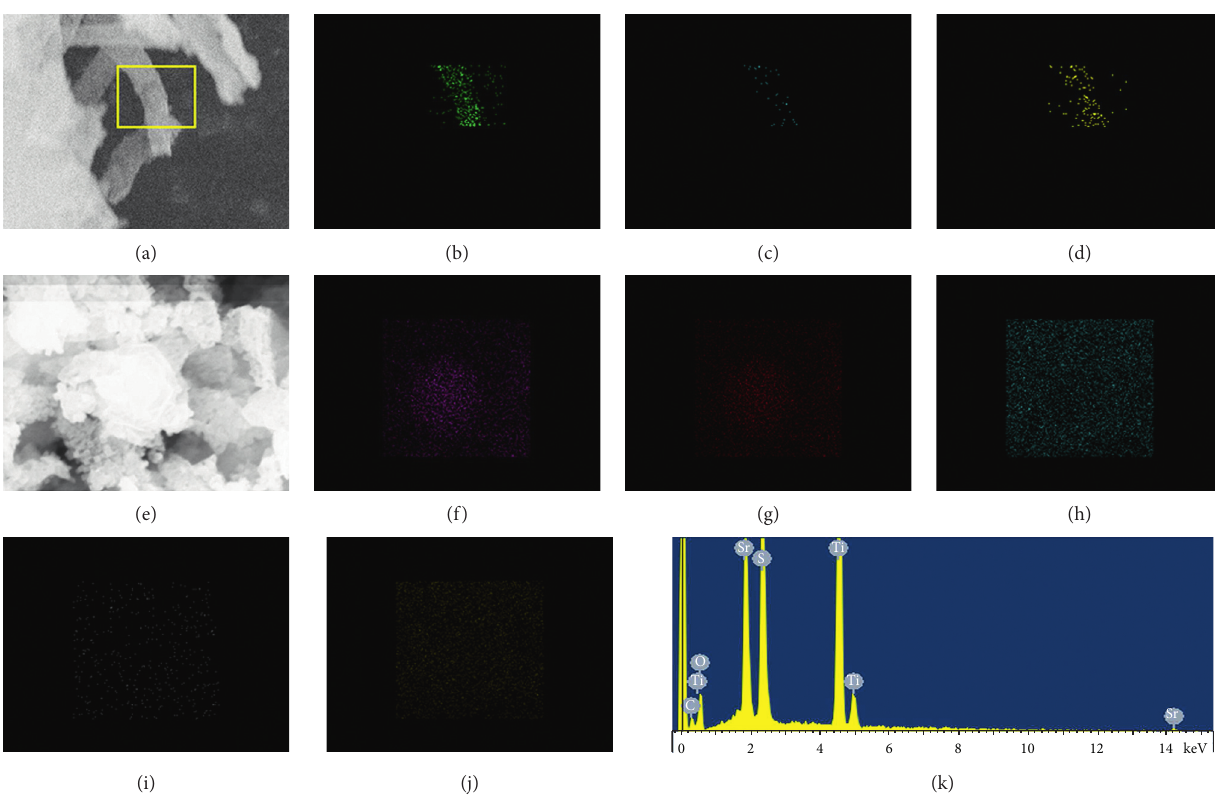
Figure 2: SEM image of (a) porous SrTiO 3 nanofibers with (b–d) Ti/S/Sr elemental mapping and SEM image of (e) SrTiO 3 @MoS 2 composite nanofibers with (f–j) Mo/S/Ti/S/Sr/O elemental mapping and (k) EDX images of SrTiO 3 @MoS 2 composite nanofibers.